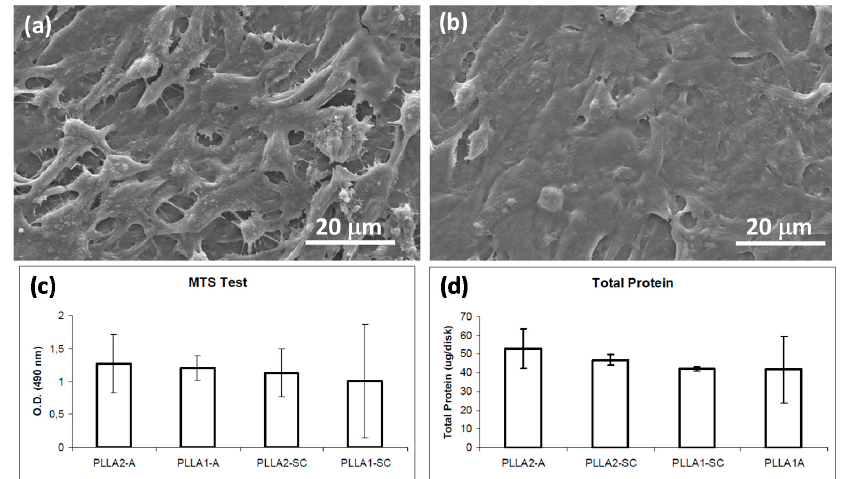
Figure 7. SEM micrographs of human osteoblasts like cells after two weeks in culture ( a ) amorphous PLLA1; ( b ) semi-crystalline PLLA1; ( c ) Cell viability measured from the optical density (O.D.) at 490 nm; and ( d ) Cell proliferation assays on SaOS-2 cells grown on PLLA disks, (PLLA1—low molecular weight; PLLA2—high molecular weight; A—amorphous; SC—Semi-crystalline) [59].